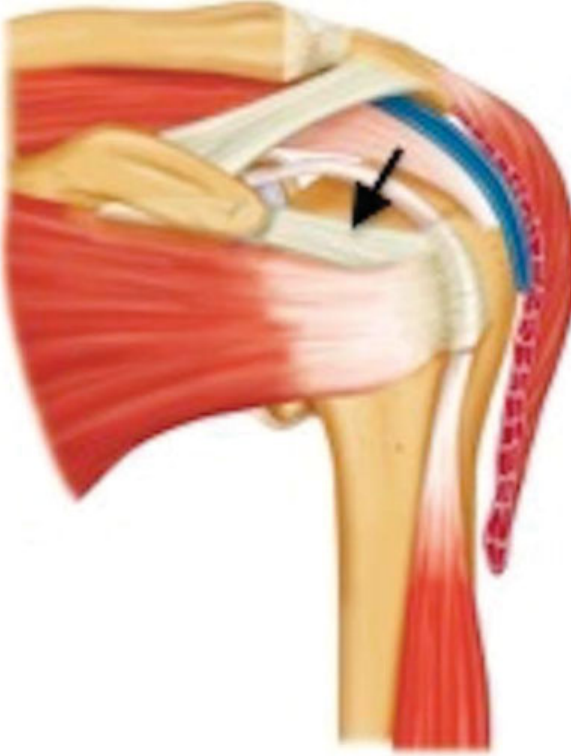
Fig. 1 Anatomy of the shoulder ( arrow indicates the coracohumeral ligament).